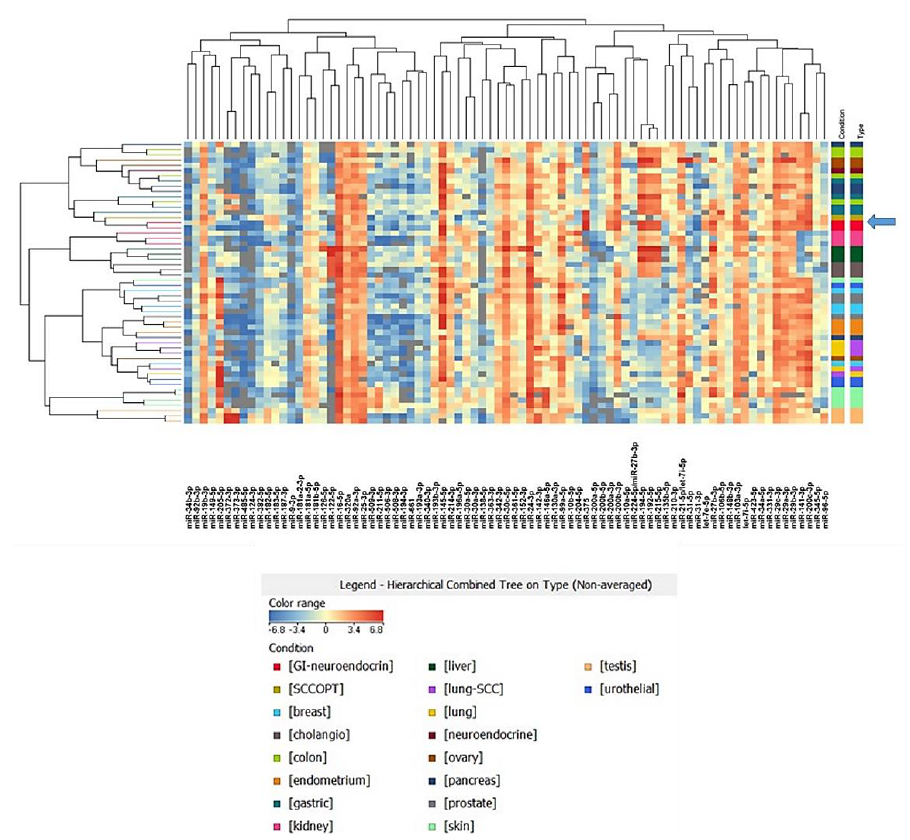
Figure 2. Cluster analysis of SCCOPT (indicated by the arrow) and 79 samples from 17 different cancer types based on the expression of tumor-specific miRNAs detected with droplet digital PCR. Pearson correlation was used as a measure of similarity among samples. Table 1. Most expressed MiRNAs in the SCCOPT sample. MiRNA copies were quantified using droplet digital PCR and normalized on SNORD44 expression.